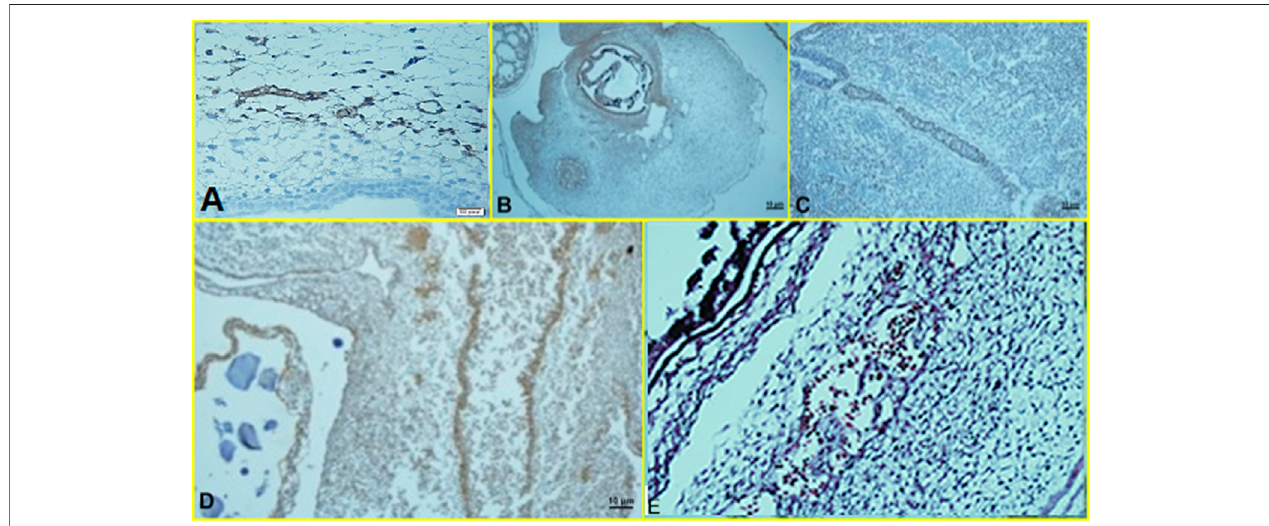
FIGURE9| Microscopyimages ofIHC stainingofCD34 from chickembryo (A) controlgroup, (B) Amp B1X, (C) Amp B2X, (D) AmBisome1X, (E) AmBisome2X.